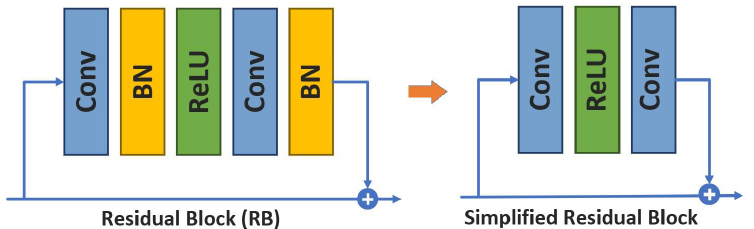
Figure 3. Simplified residual block by remove batch normalization layer.